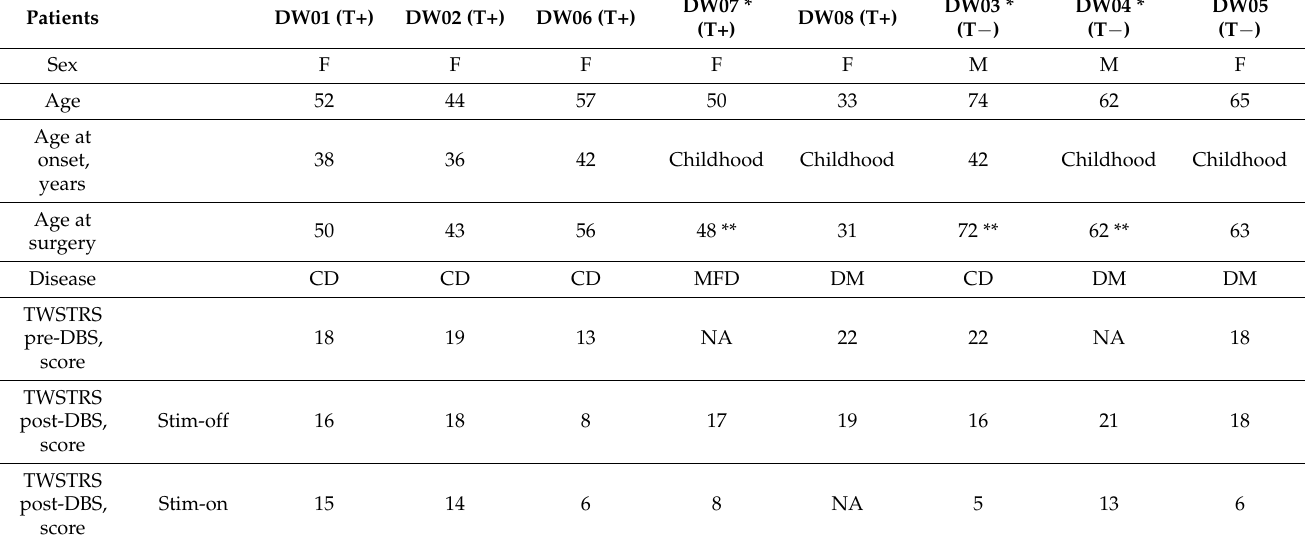
Table 1. Demographic and clinical data. Abbreviations: T+—patients with head tremor; T − —patients without head tremor; CD—cervical dystonia; MFD—multifocal dystonia; DM—dystonia with